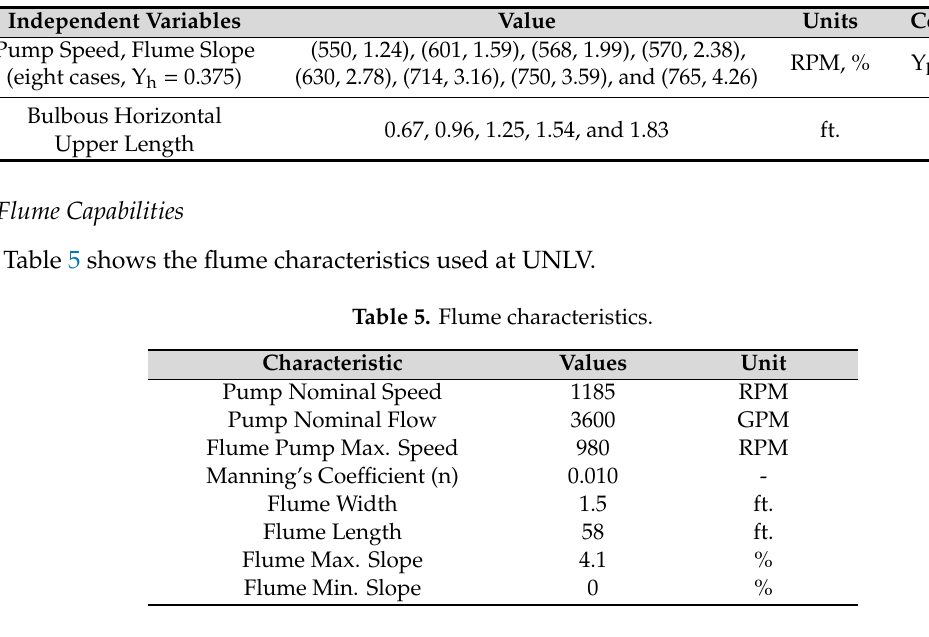
Table 4. The test matrix.